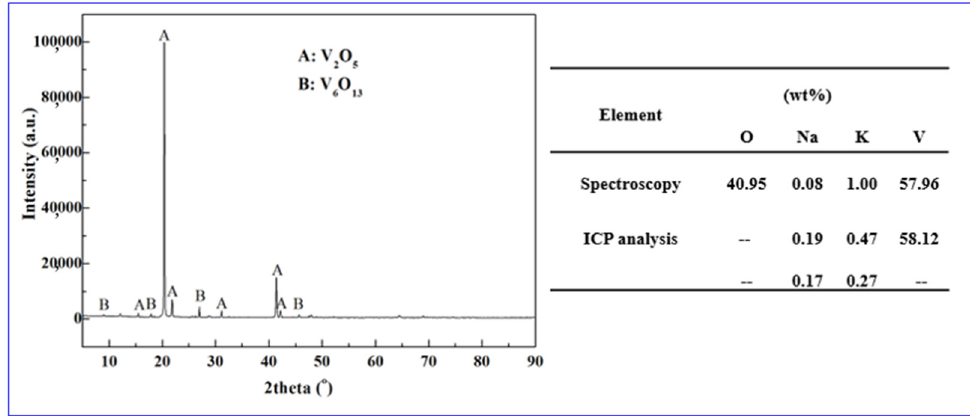
Figure 4. Phase composition analysis and element content analysis results of vanadium pentoxide.